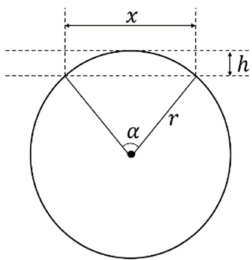
Figure 2. Layout for the measurement of the depth of the indentation after 24